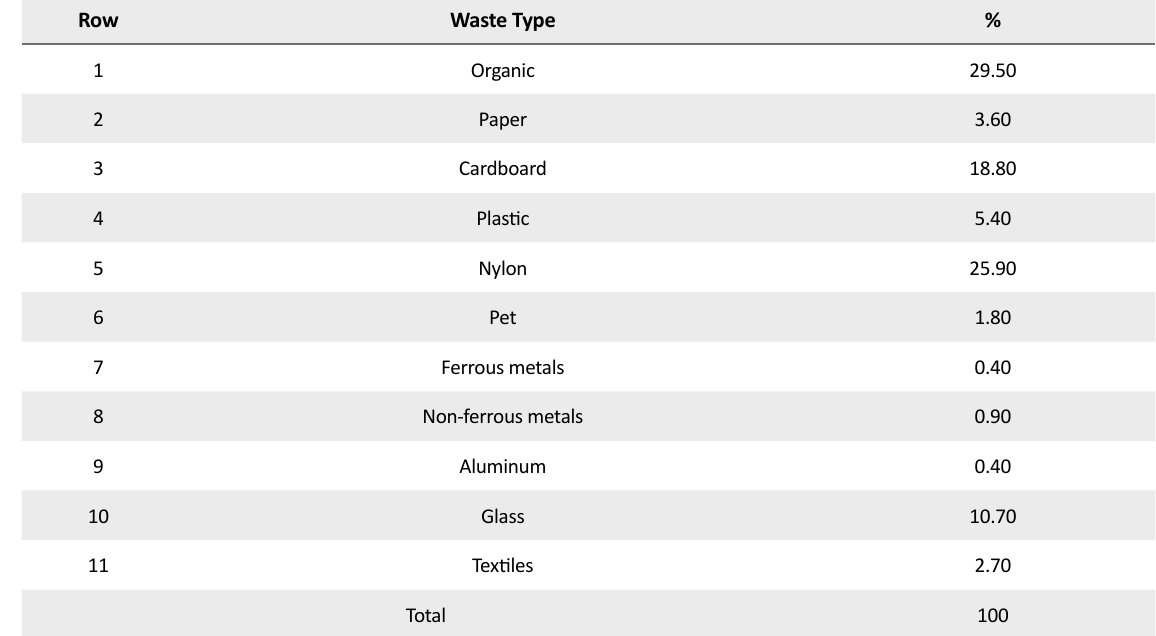
Table 1. Average physical analysis of Kerman Graduate University of Technology waste Row Waste Type